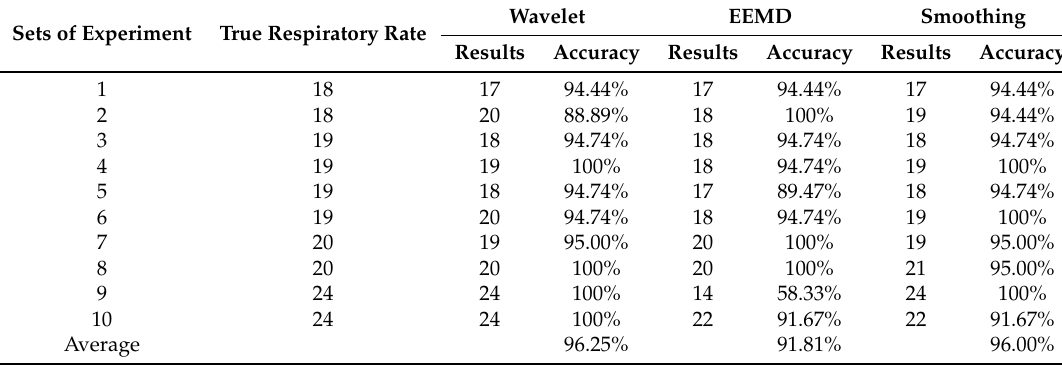
Table 2. The results of the respiratory rate test with the time period of 30 s. Sets of Experiment